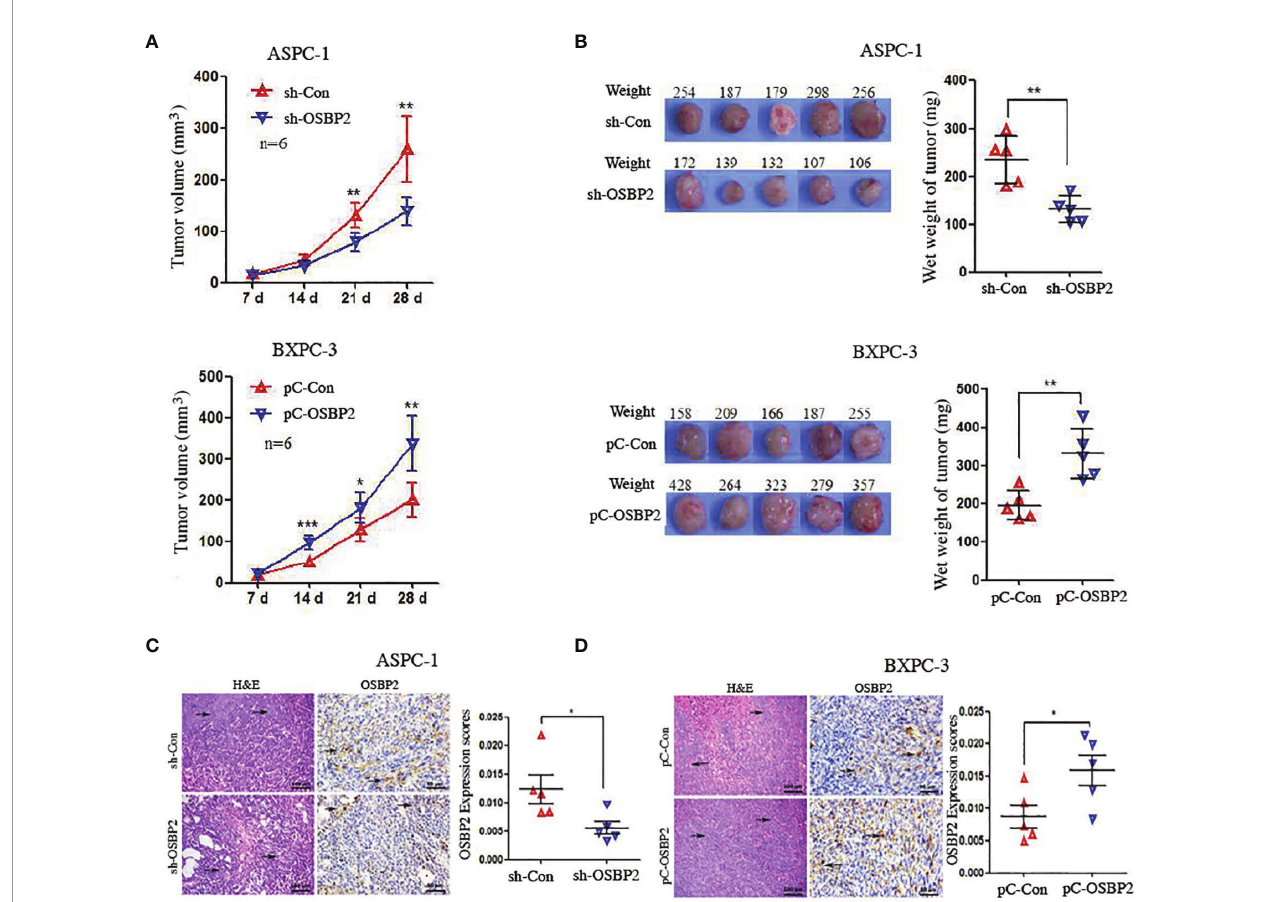
FIGURE 6 | OSBP2 promotes the proliferation of PDAC cells in vivo. (A) OSBP2 knockdown decreased the tumor formation capacity of ASPC-1 cells, and OSBP2 overexpression increased the tumor formation capacity of BXPC-3 cells, as observed in xenograft models. (B) Photographs of excised tumors from nude mice and the tumor weights calculated at the end of the experiment are shown in the right panel. (C, D) Pathologic analysis of tissue sections from recipient mice at 4 weeks post-injection. H&E (magni fi cation, 200×) and OSBP2 staining (magni fi cation, 200×) were performed. Normalization of OSBP2 expression is shown on the right. OSBP2, oxysterol-binding protein 2; PDAC, pancreatic ductal adenocarcinoma; sh, shRNA; pC, pcDNA3.1 plasmid. *P < 0.05, **P <